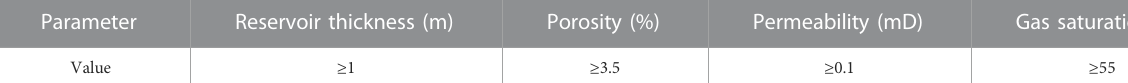
TABLE 3 Evaluation parameter table of the favorable zone of fi ne siltstone gas in eastern Ordos.